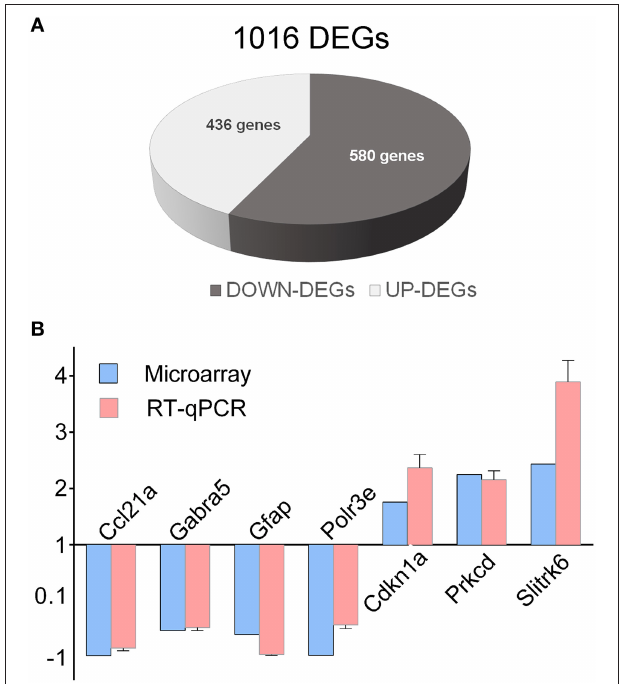
FIGURE 2 | DEGs commonly expressed in the BTBR and En2 − / − hippocampus. (A) Venn diagram of differentially expressed genes in the BTBR and En2 − / − adult hippocampus. A total of 1016 and 862 differentially expressed genes were identified in BTBR (brown) and En2 − / − (gray) mice, respectively. Among these, 153 show differential expression in both strains. The table shows a subset of these common DEGs, all belonging to inflammatory pathways. (B) qRT-PCR validation of Ccnd1 and Pglyrp1, two genes differentially expressed in both BTBR and En2 − / − hippocampi. qRT-PCR results for both genes were in agreement with microarray results. Values are expressed as each gene/L41 comparative quantitation ratios normalized on the expression of respective control (mean ± s.e.m of three replicates from pools of six animals per genotype; p < 0.05, Student ’ s t -test, BTBR vs. B6 and En2 − / − vs. En2 + / +